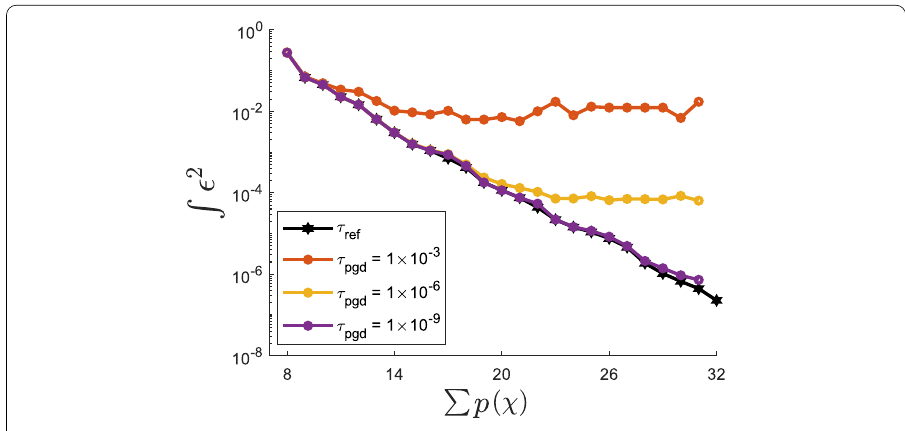
Fig. 9 Comparison between the reference simulation τ ref and the results with different tolerances for the integral of the energy of the error as a function of the combination of polynomial degrees